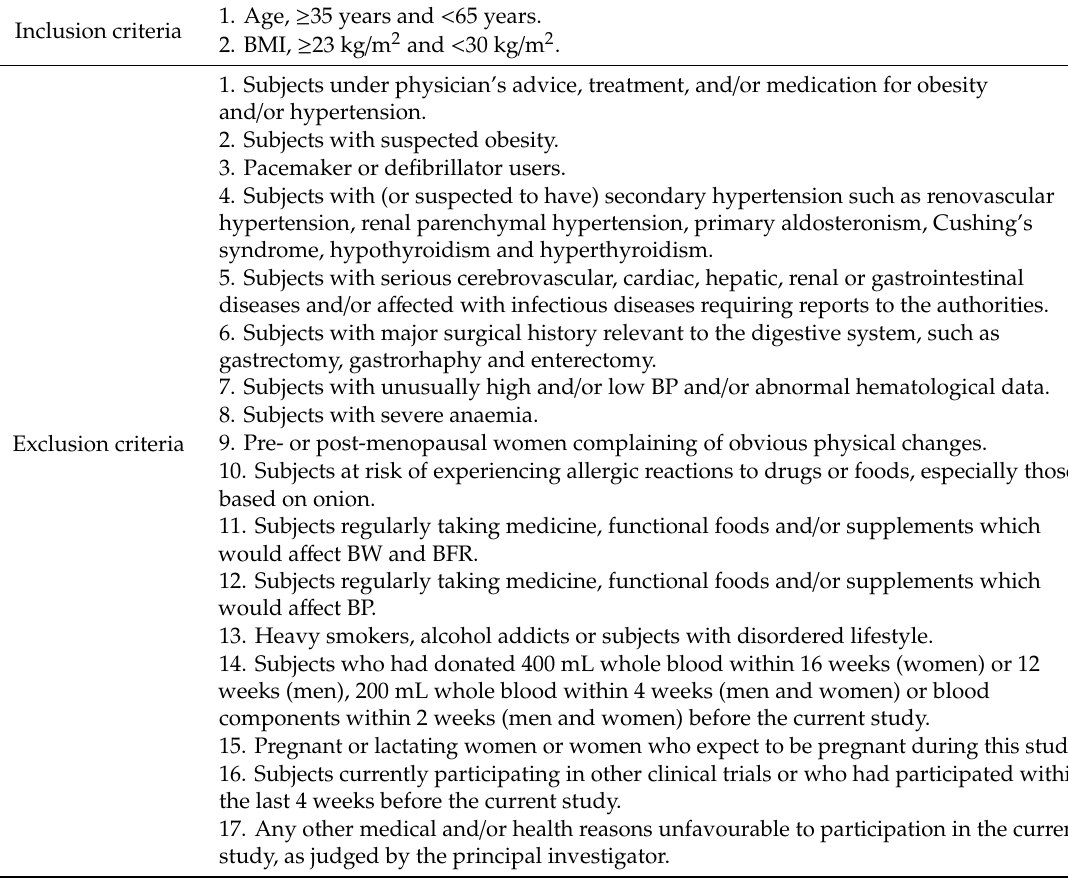
Table 2. Inclusion and exclusion